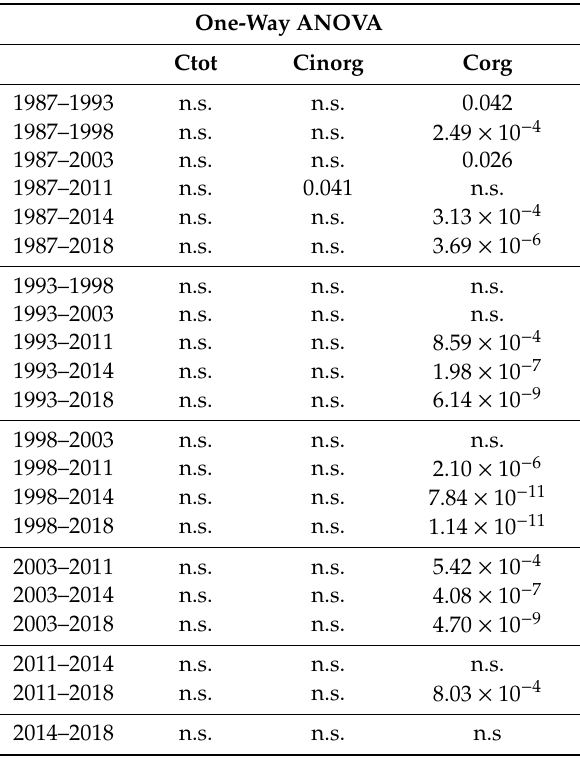
Table 2. Statistical correlations ( p -value) between carbon species (Ctot, Corg and Cinorg) during di ff erent sampling periods in the central part of the Venice Lagoon; n.s.: not significant.